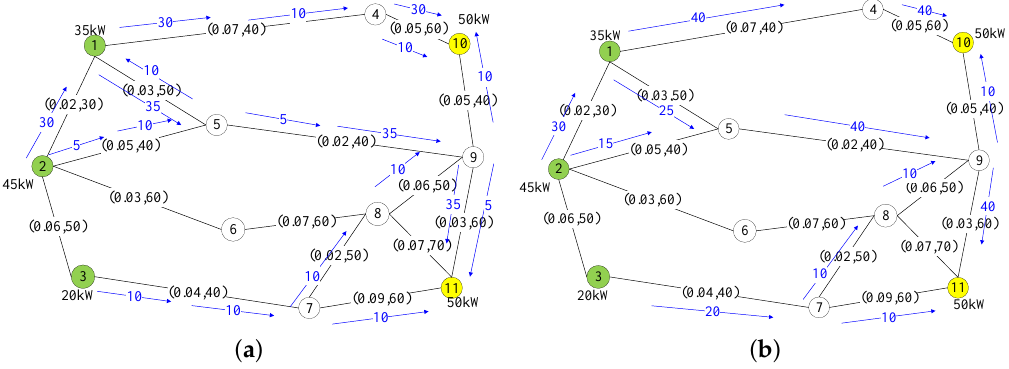
Figure 4. Paths selected by greedy smallest-cost-rate path first (GRASP) on a simple network. ( a ) Paths selected by GRASP on a simple network indicating each power flow. ( b ) Paths selected by GRASP on a simple network indicating the aggregated